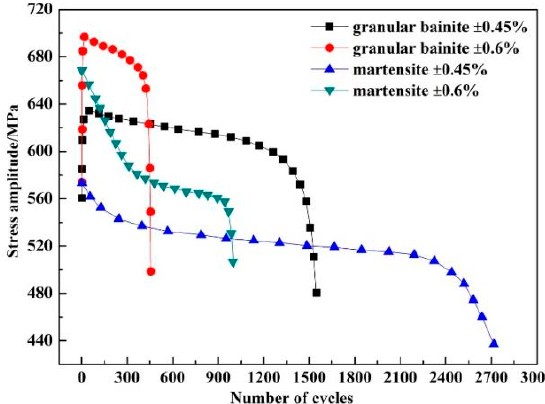
Figure 4. Fatigue life cycles curve of specimens with granular bainite and martensite at different strain amplitudes [40].